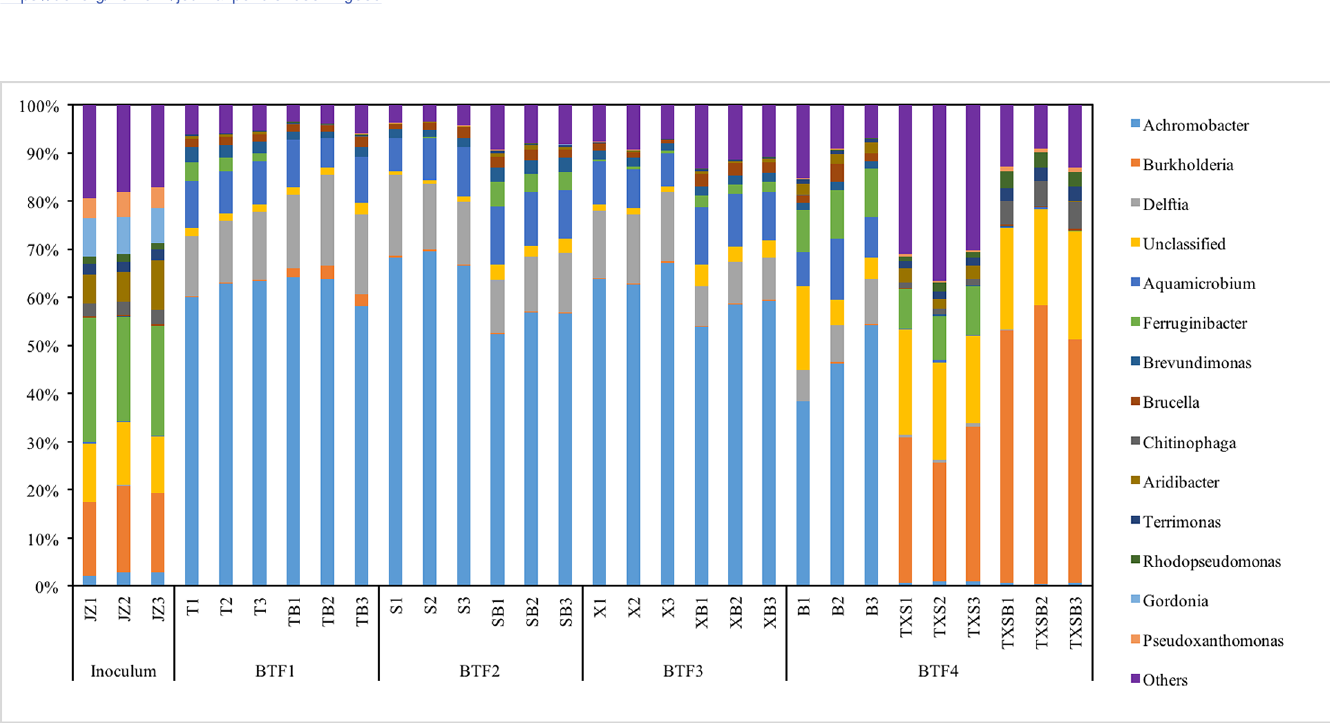
Fig 6. Microbial community structures of 30 samples from 9 treatments and the original inoculums. B: benzene; T: toluene; X: xylene; S: styrene; JZ: inoculum; BTF: Biotrickling filter.